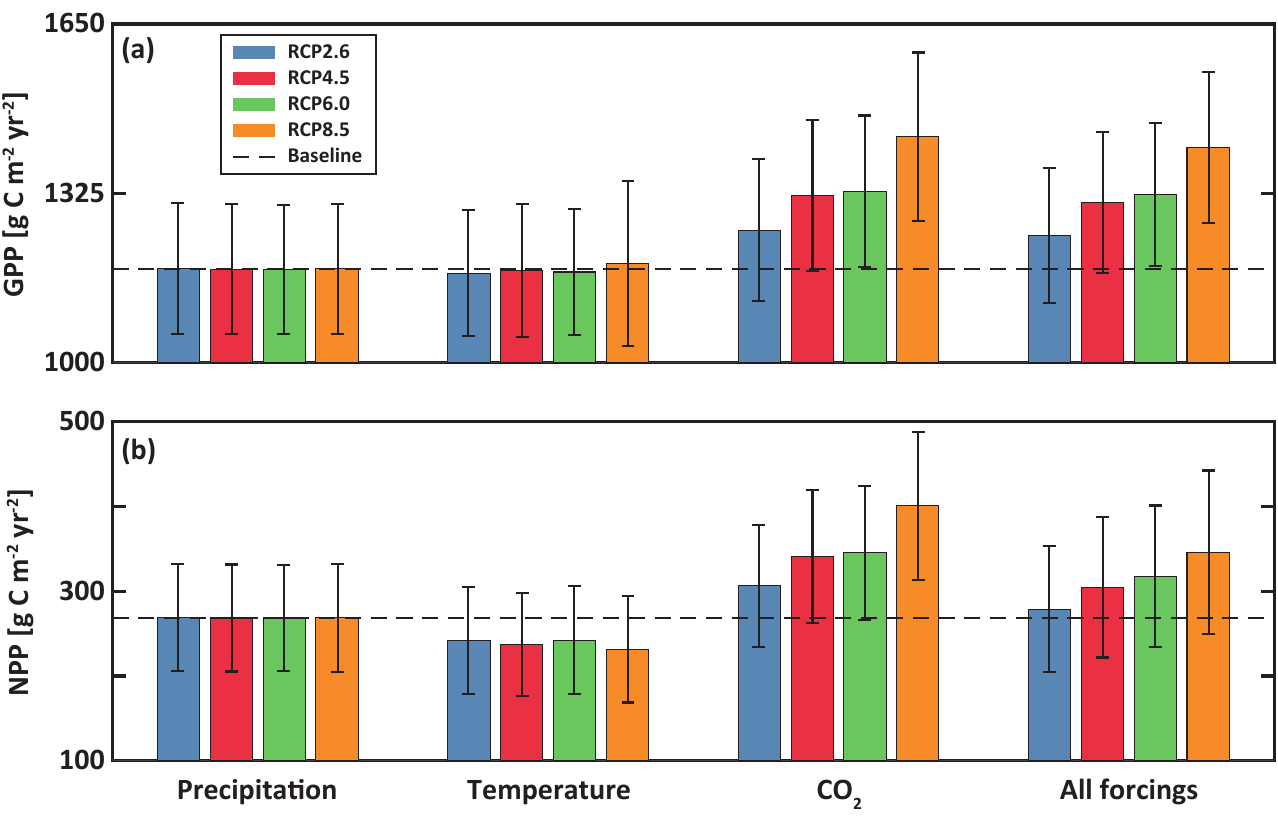
Figure 3. Projected ( a ) GPP and ( b ) NPP over the 50-year study period for the scenario of precipitation change alone (first column), temperature change alone (second column), CO 2 change alone (third column), and all together (fourth column) under RCP 2.6 (blue), 4.5 (red), 6.0 (green), and 8.5 (orange) for the 2050s (from 2036 to 2065). Error bars are standard deviations. The variables at baseline, climate conditions based on the 2010s (from 1986 to 2015), are shown in dashed